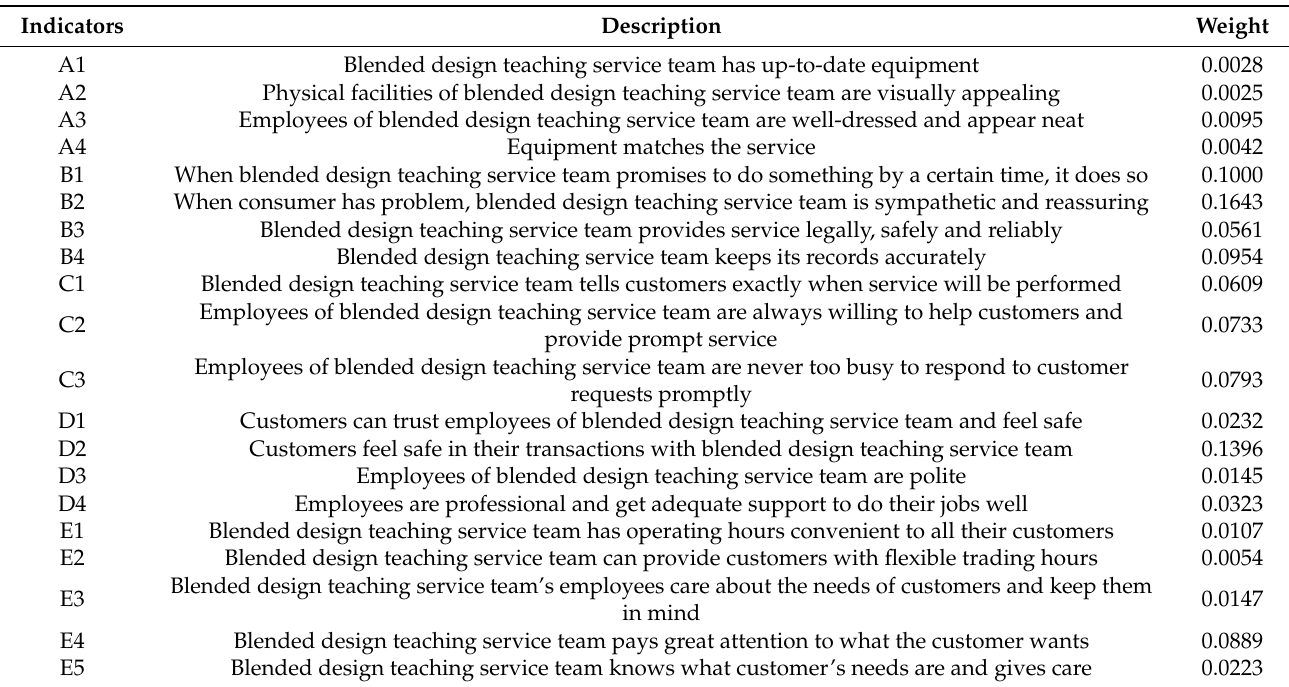
Table 12. The weight of all indicators in FANP model.